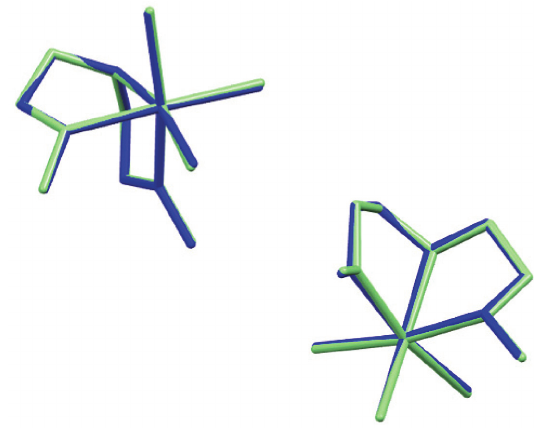
Figure 3. Structure overlay of isostructural complexes 1 , [ VCl (diglyme) ] , in blue and TiCl 3 atoms are omitted for